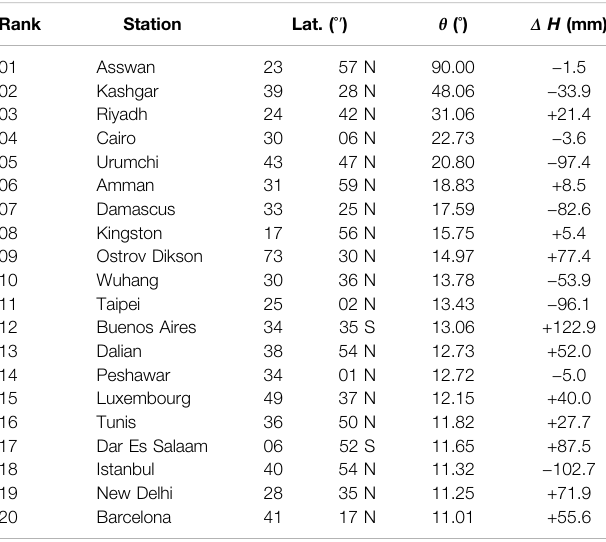
Paz, Lima, Maputo, and Honiara are excluded.